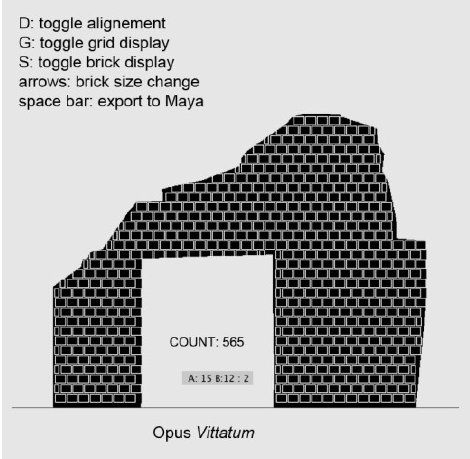
Figure 4. Opus Vittatum represented by